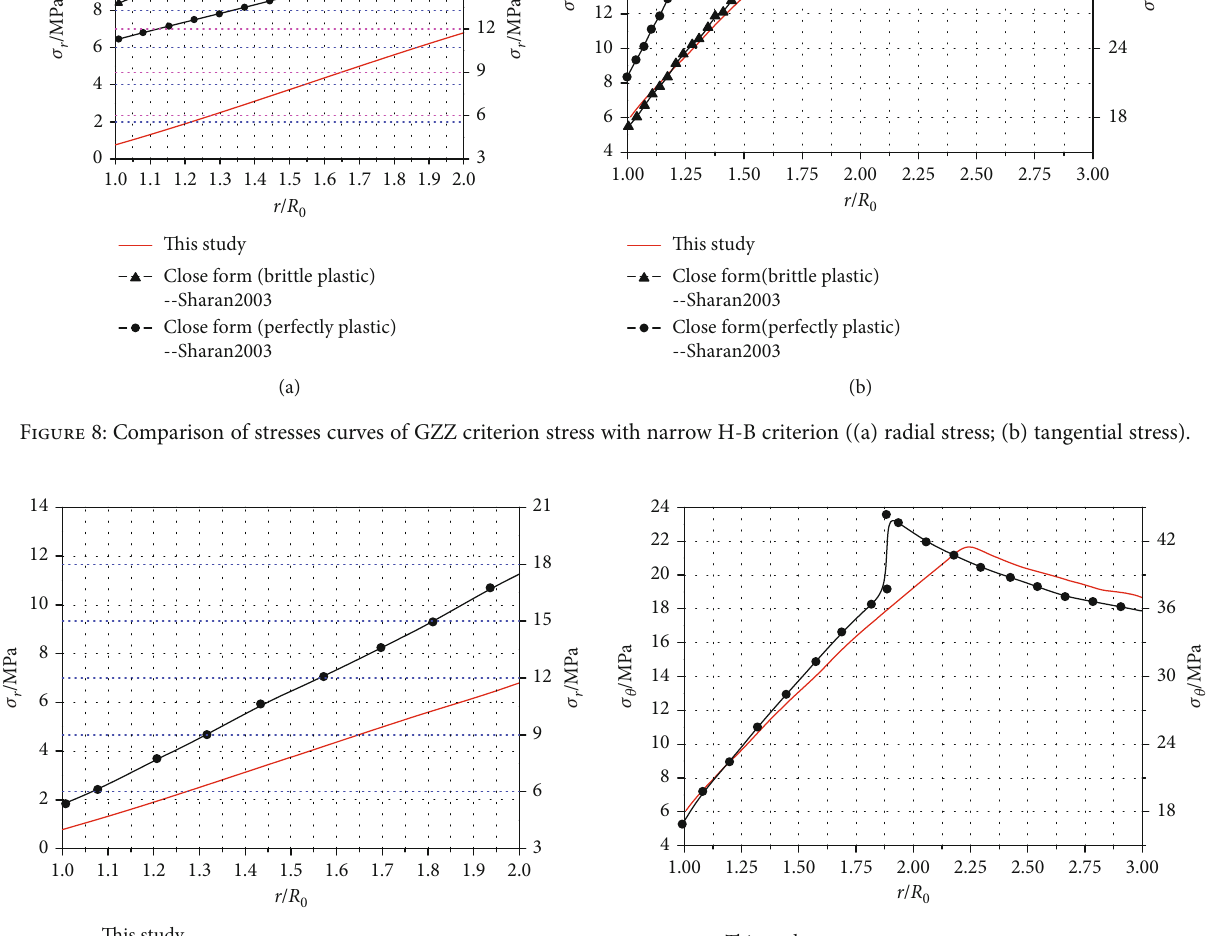
1.0 1.1 1.2 1.3 1.4 1.5 1.6 1.7 1.8 1.9